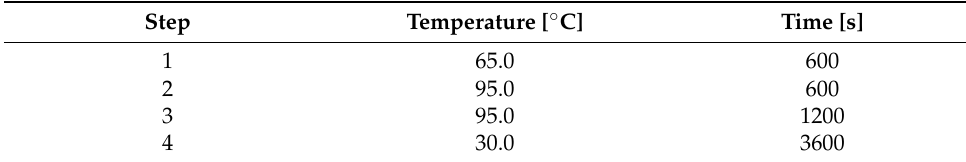
Table 4. Settings for baking after exposure.